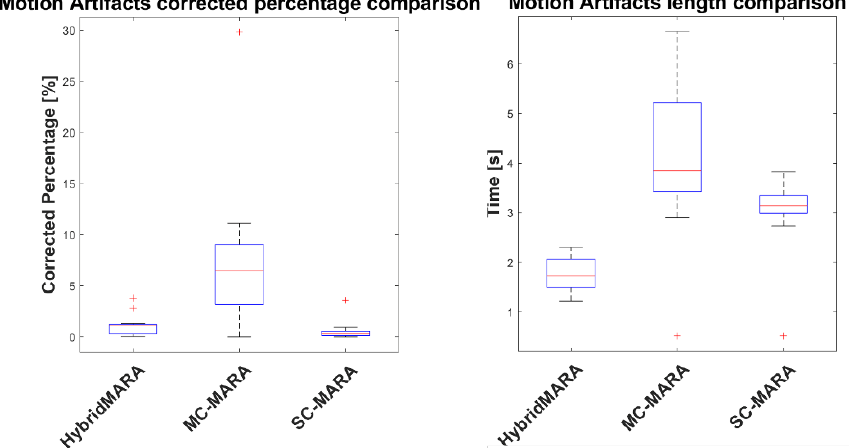
Figure 3. Boxplot comparison of averaged MA percentage ( left ) and temporal length ( right ) across subjects and measurement channels. Cross symbols outside interquartile ranges indicate data outliers.